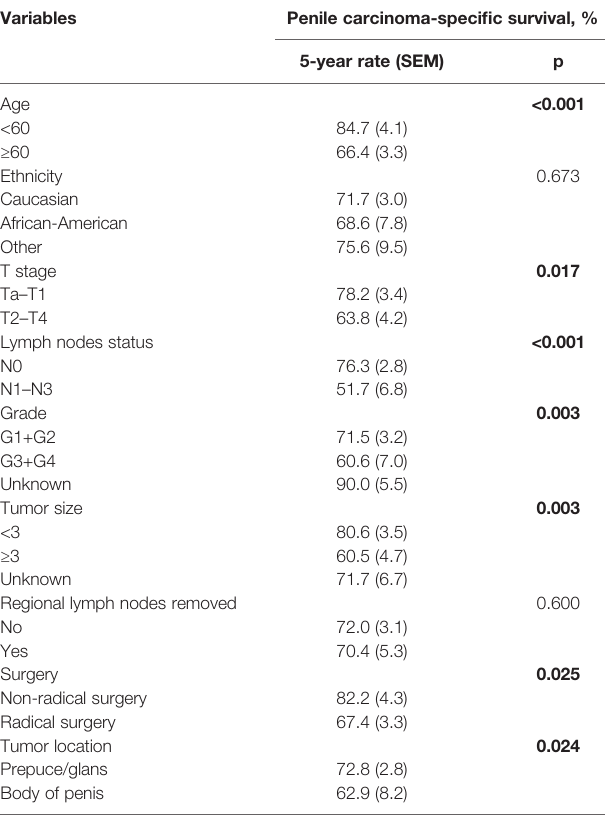
ethnicities (p = 0.003, Figure 3C ), T2 – T4 stage (p = 0.036, Figure 4B ), tumor size ≥ 3 cm (p = 0.001, Figure 5B ), no regional lymph nodes removed (p = 0.044, Figure 6A ), and radical surgery (p = 0.027, Figure 7B ). However, there were no